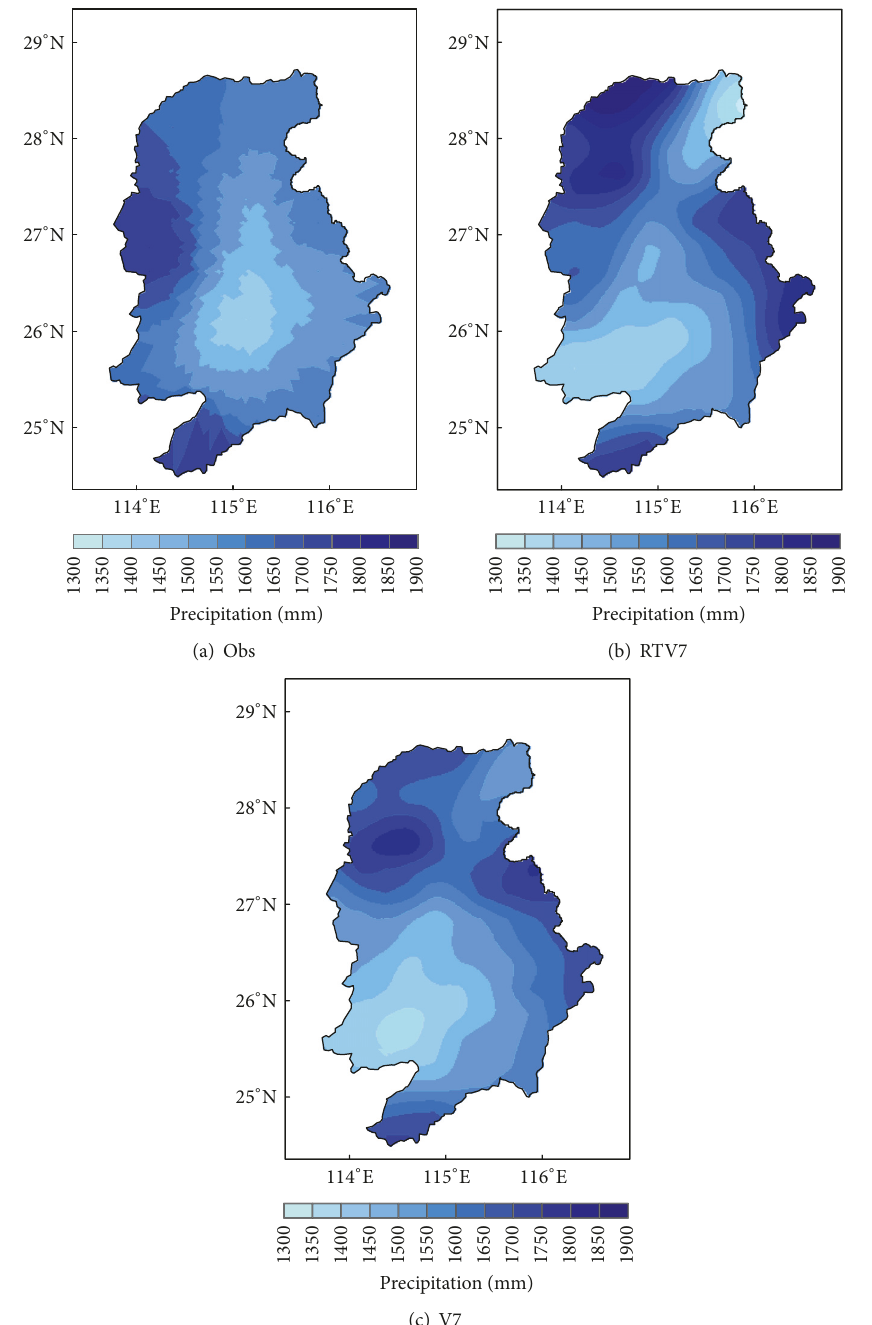
Figure 2: Spatial distribution of annual mean precipitation in the Ganjiang River basin from TMPA and observed data from 2003 to